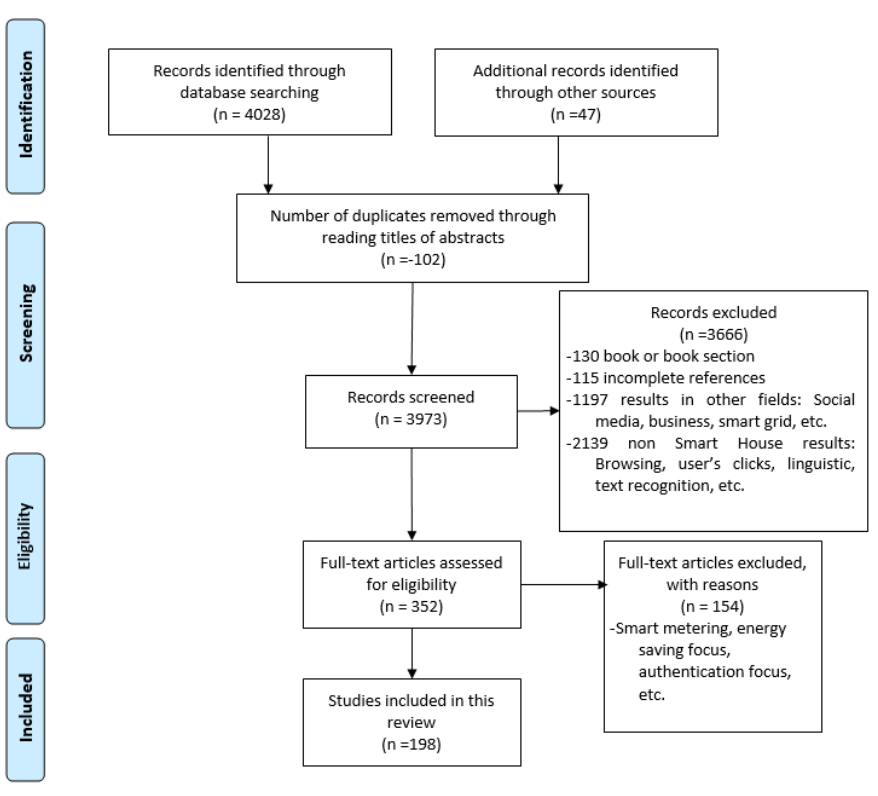
Figure 2. Database